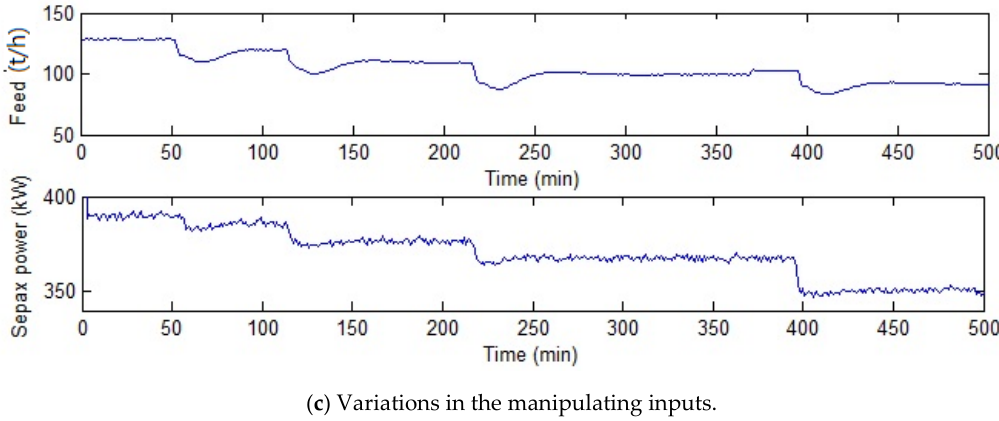
Figure 5. Variations in the different process and manipulating variables when GPC is implemented in a real-time cement plant simulator.